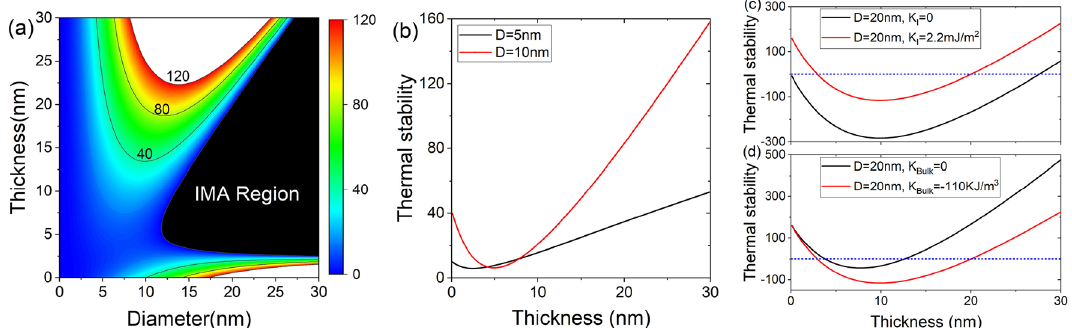
Figure 2. ( a ) Thermal stability as a function of thickness t f and diameter D . ( b ) Thermal stability as a function of t f for a given D = 5 and 10 nm. ( c ) Comparison of thermal stability for K I = 0 and K I = 2.2 × 10 − 3 A/m 2 for a given D = 20 nm. ( d ) Comparison of thermal stability for K Bulk = 0 and K Bulk = − 1.1 × 10 5 A/m 3 for a given D = 20